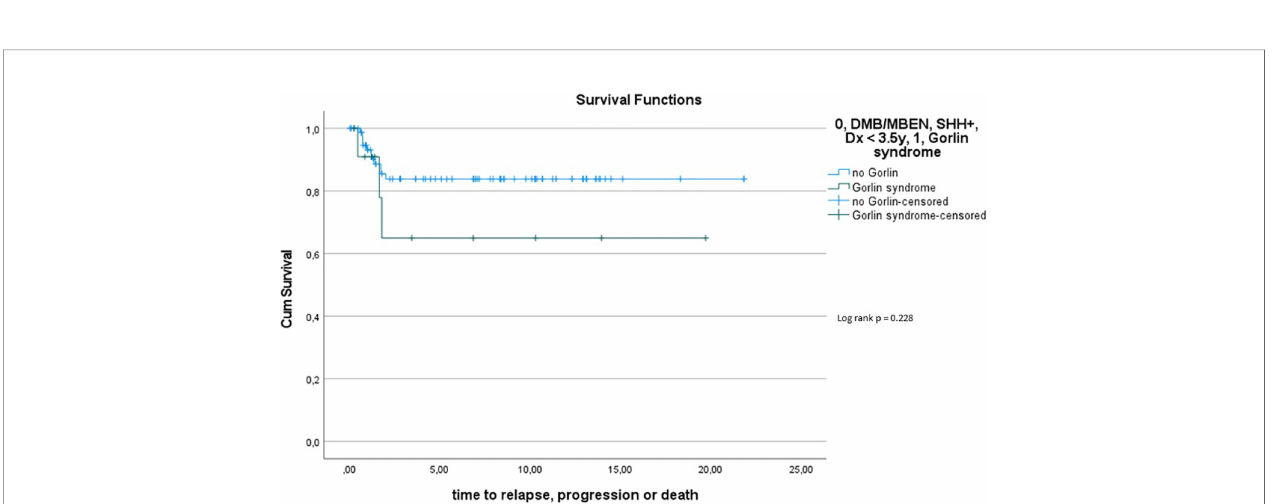
FIGURE 7.2 | PFS for all SHH +, MBEN/DMB, <3.5 vs . all Gorlin